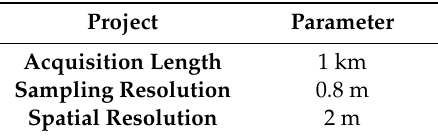
Figure 10 . Winding original temperature.